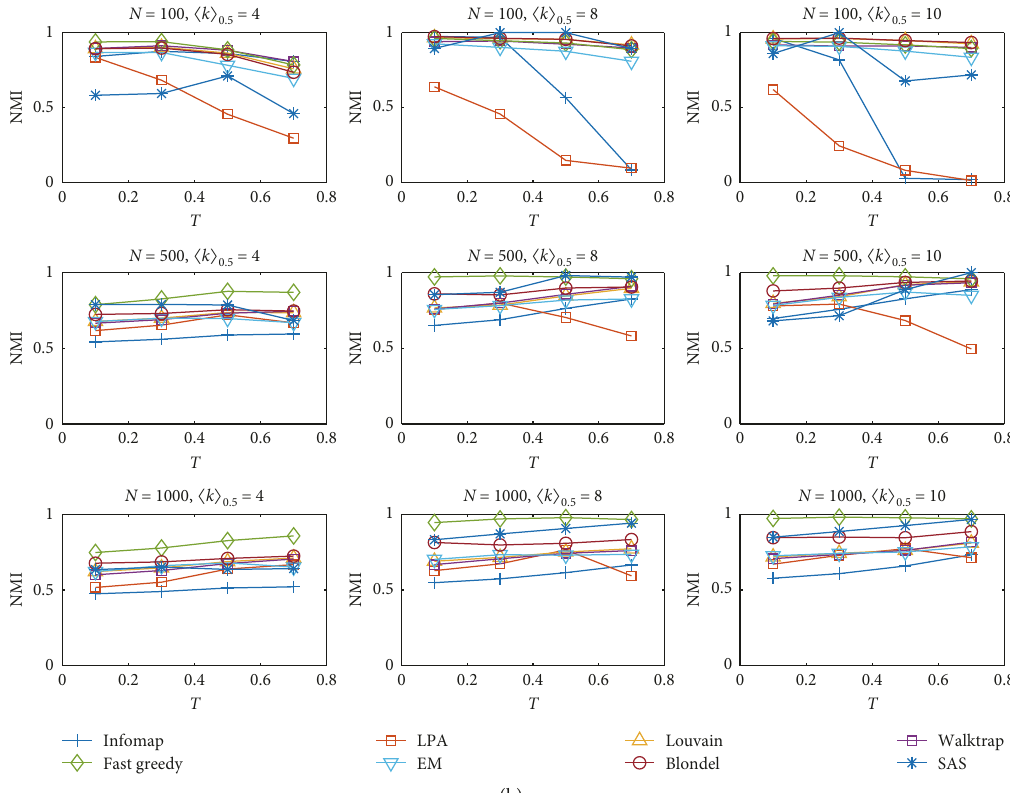
Figure 8: Community detection on nPSO networks. For each combination of parameters, 100 networks have been generated. And for each network, the community detection methods Infomap, LPA, Louvain, Walktrap, Fast greedy, EM, and Blondel have been executed. The communities detected have been compared by computing the normalized mutual information (NMI). The number of communities n and the parameter c nPSO is 2 and 3 in (a) and (b), respectively. The parameters β � 3, c � 0 . 9, and ρ � 0 .